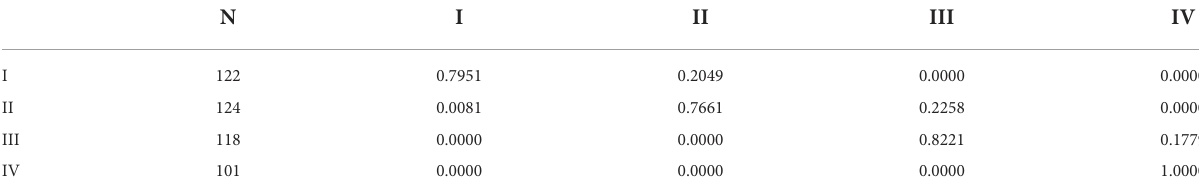
TABLE 5 Traditional Markov probability transfer matrix of the MHSS level in China from 2005 to 2020. N I